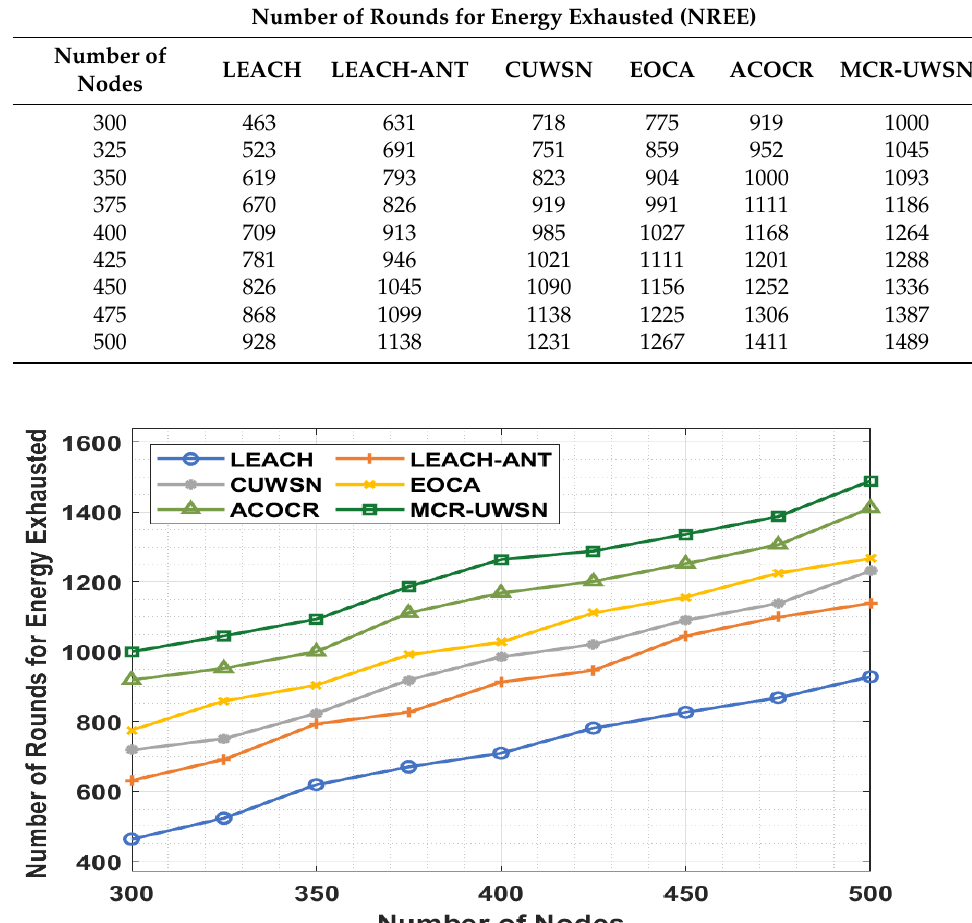
Figure 6. NREE analysis of MCR-UWSN method with existing approaches.